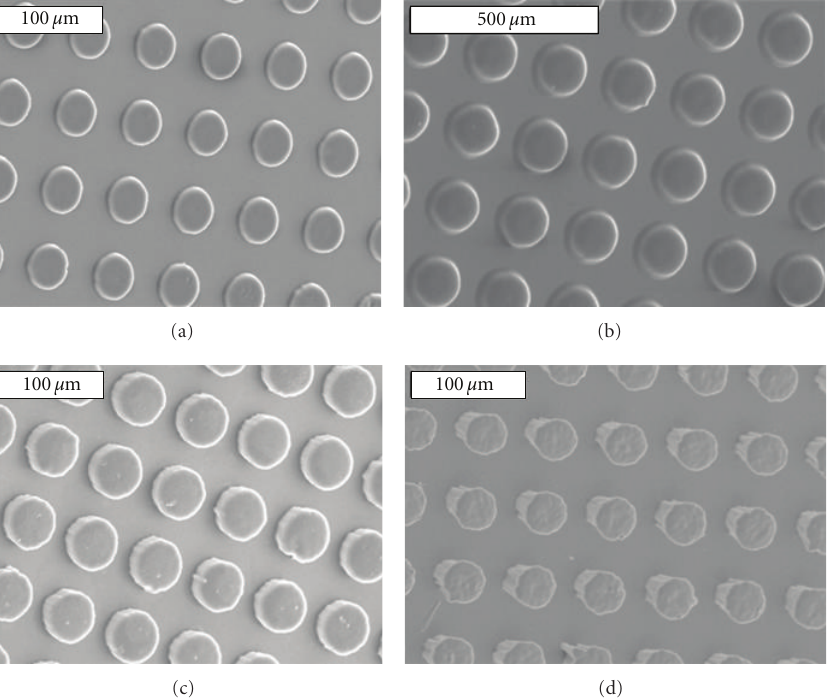
Figure 17: D40-B SEM image of each scale (a) the first scale (34 µ m), (b) the second scale (23 µ m), (c) the third scale (13 µ m), and (d) the forth scale (6 µ m).